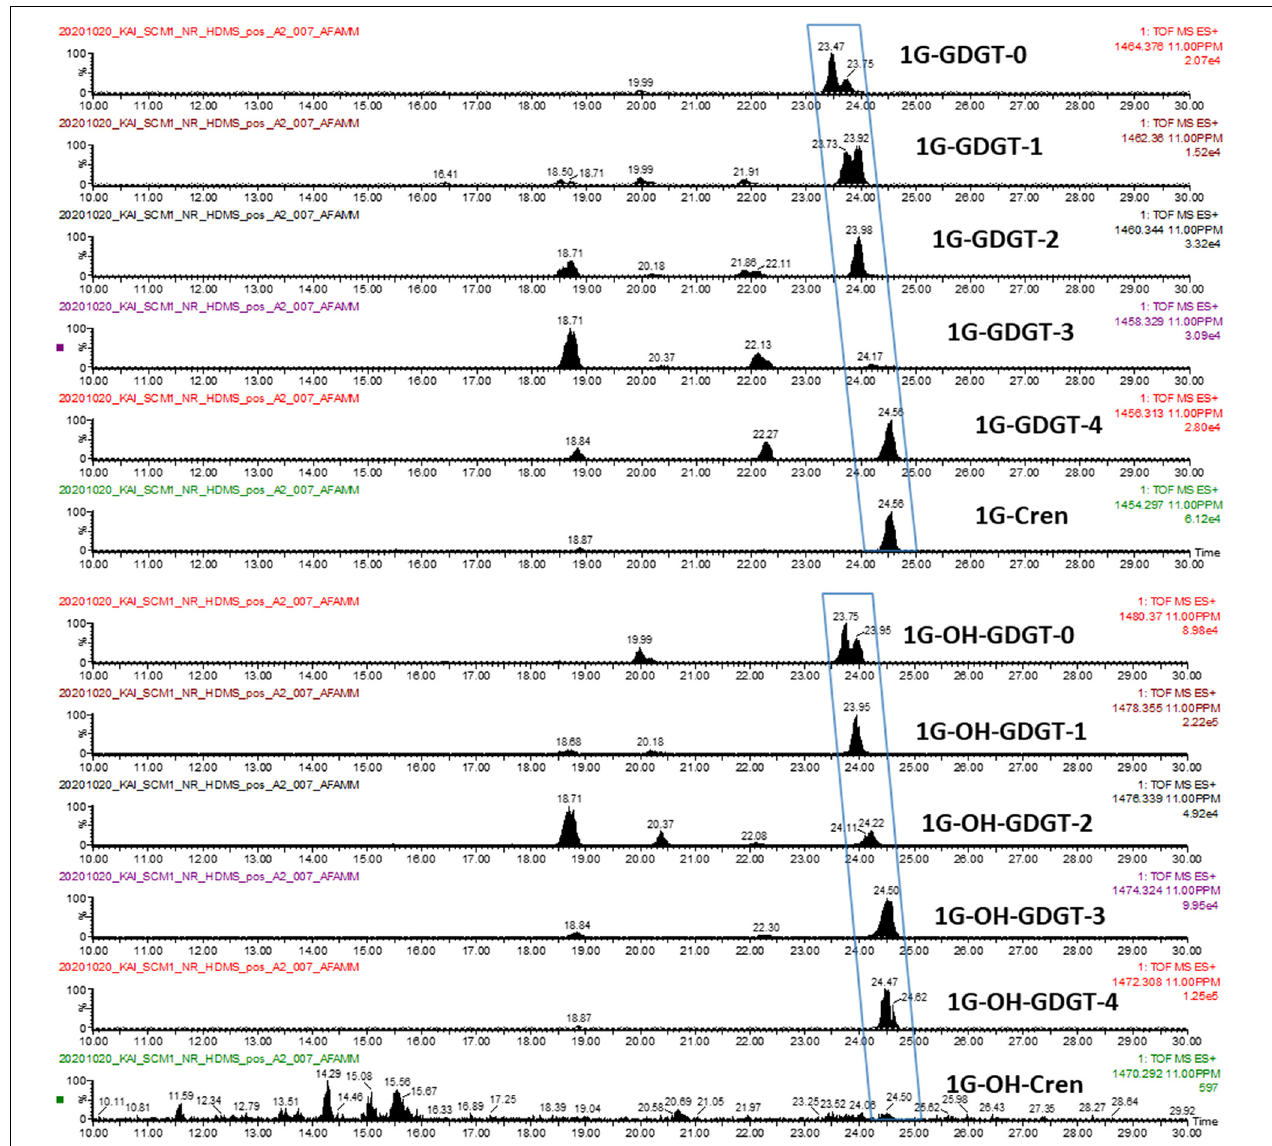
FIGURE 10 | Manual curation: EICs of 1G-GDGTs (top) and 1G-OH-GDGTs (bottom) [M + H] + ions.